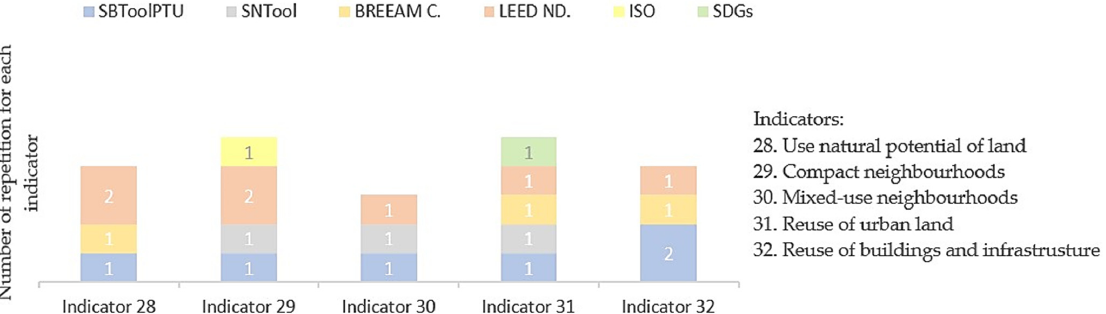
Figure 8. Frequency distribution of each indicator, relevant to the category of land use and infrastructure in SBTool PT _Urban (2018), SNTool Min (2020), BREEAM-C (2012), LEED-ND (2018), ISO 37120, and SDGs.